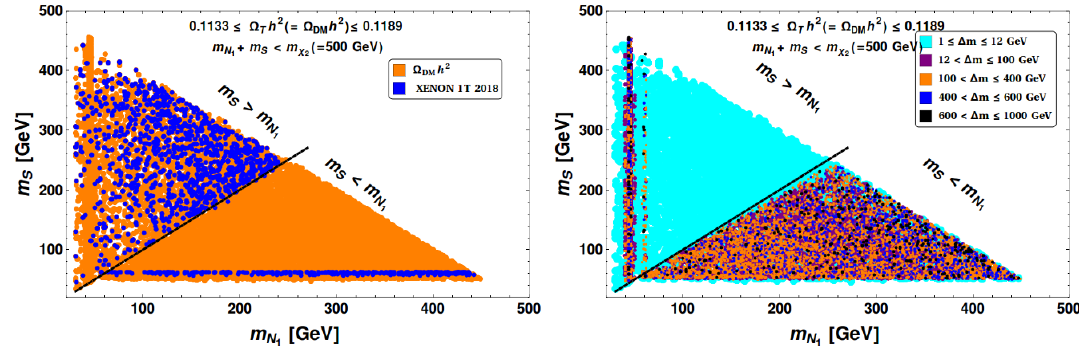
m S plane. [Left Panel] Relic den- 1 (cid:0) = m S 1 and the region 1